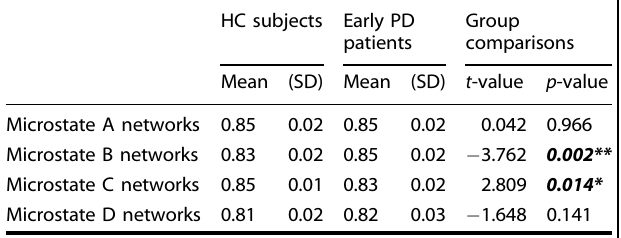
Signi fi cant differences are displayed in bold and italics type. SD standard deviation. Adjustment for multiple comparisons: FDR. Signi fi cant statistical difference with * p <0.05 and ** p <